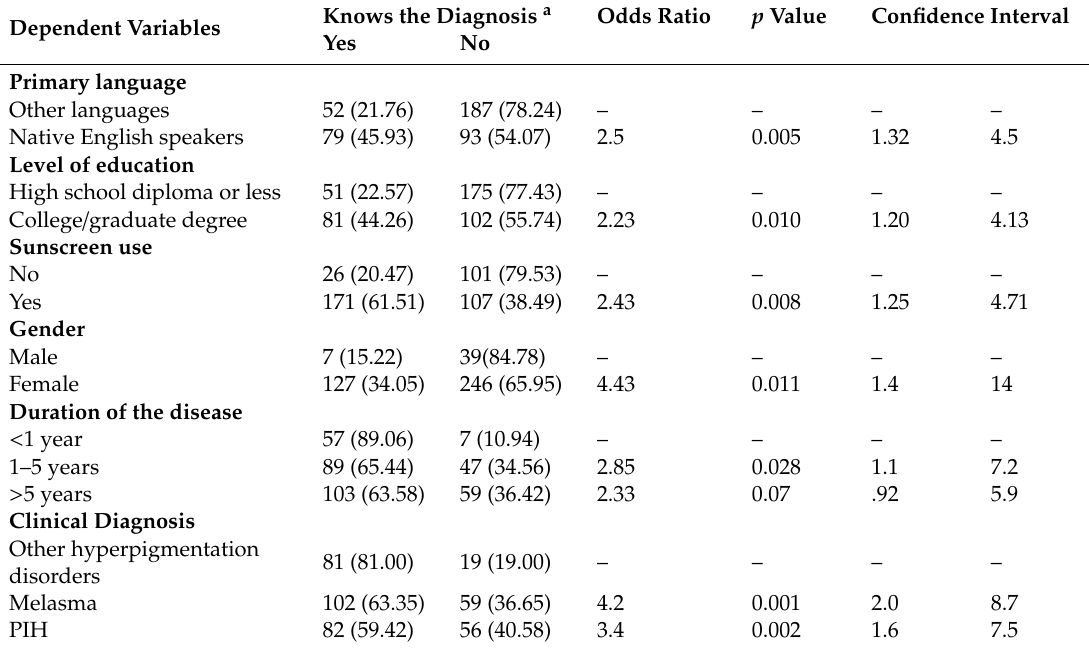
Table 2. Factors associated with knowing the diagnosis among patients with sun-exacerbated